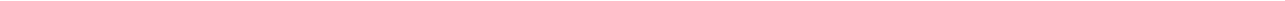
Fig. 4 IL-7R α is polyglutamylated at Glu446 by TTLL4 and TTLL13 . a Gene expression levels of Ttll1 , Ttll2 , Ttll4 , Ttll5 , Ttll6 , Ttll7 , Ttll9 , Ttll11 , and Ttll13 were examined in α LPs and CHILPs by real-time qPCR. Relative fold changes of gene expression values were normalized to endogenous Actb . b Ttll4 and Ttll13 expression patterns were analyzed in hematopoietic populations as in a . c rGST-IL-7R α bound to Flag-TTLL4 and Flag-TTLL13 by pulldown assay. d Myc-IL-7R α with Flag-TTLL4 or Flag-TTLL13 were co-transfected in 293T cells for 36 h, followed by immunoblotting assay. e CHILPs were incubated with antibodies against TTLL4, TTLL13, and IL-7R α by immuno fl uorescence staining. IL-7R α , green ; TTLL4 and TTLL13, red ; nucleus, blue . Scale bar , 2 μ m. f rGST-IL-7R α was incubated with TTLL4 and TTLL13 for in vitro glutamylation assay. g TTLL4- and TTLL13-mediated rGST-IL-7R α glutamylation was removed by CCP2. h Flag-TTLL4 and Flag-TTLL13 with Myc-IL-7R α -wt or Myc-IL-7R α -E446A were transfected into 293T cells. Cell lysates were immunoprecipitated by anti-Myc antibody and immunoblotted with indicated antibodies. i IL-7R α glutamylation was analyzed in BM cells from WT and Il7r E446A by immunoblotting. j ILC3s were analyzed in WT and Il7r E446A mice by FACS. n = 6 for each group. k Histology of colons from WT and Il7r E446A mice 8 days after infection with C. rodentium . Scale bars , 50 μ m. l Survival rates were monitored at the indicated time points with C. rodentium infection. n = 8 for each group. ** P < 0.01 (Student ’ s t -test). Data are representative of three independent experiments. Error bars in a , b , and j indicate